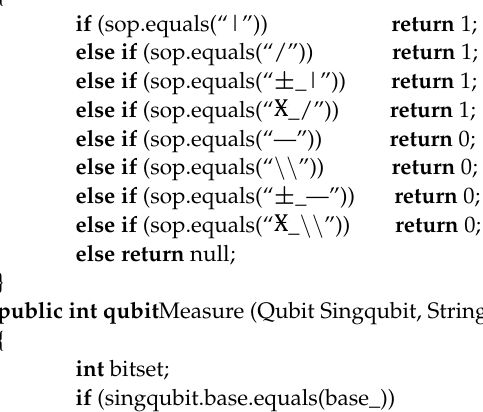
Figure 1. Design and construction of the proposed multi-bit QKD. King uses four conjugated basis to encode an arbitrary stream of bits. Individual bits where King and Singh cast off the identical basis is considered as the obtained final key.